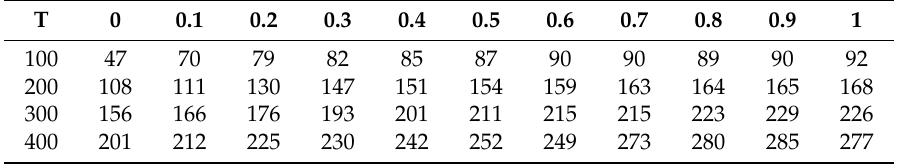
Table 2. Effects of parameter λ on the performance of the FDP based on the DIP_PPI network.